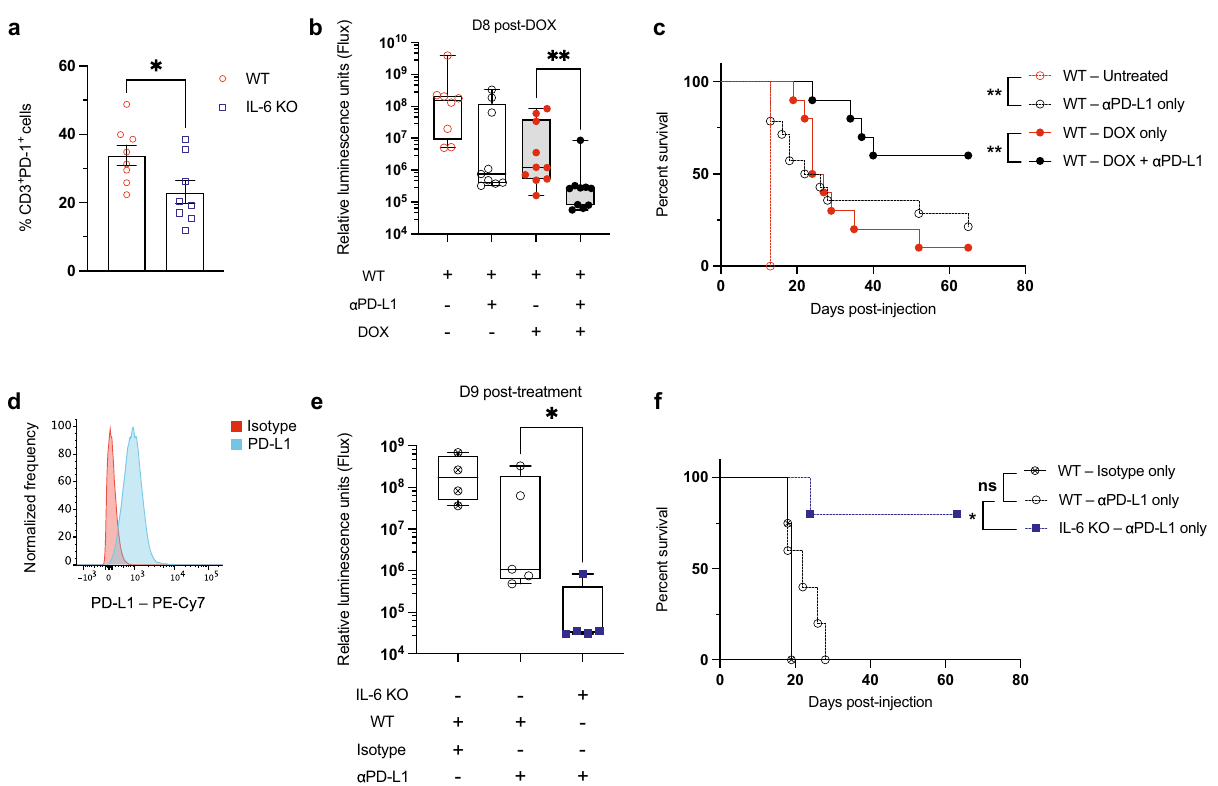
Fig. 5 Combination treatment with doxorubicin and PD-L1 inhibition increases mouse survival, while IL-6 inhibits the ef fi cacy of PD-L1 inhibition. a A graph showing CD3 + T-cell – PD-1 + percentages in the bone marrow of tumor-free WT mice in the absence of treatment. * p = 0.032 by two-tailed Student t -test. b A graph showing leukemia burden in vivo monitored by bioluminescence imaging. n = 10 per cohort, except n = 9 for both WT-untreated and WT- α PD-L1. ** p = 0.0029 by two-tailed Mann – Whitney test. c A Kaplan – Meier survival curve showing leukemic WT mice. n = 10 per cohort, except n = 5